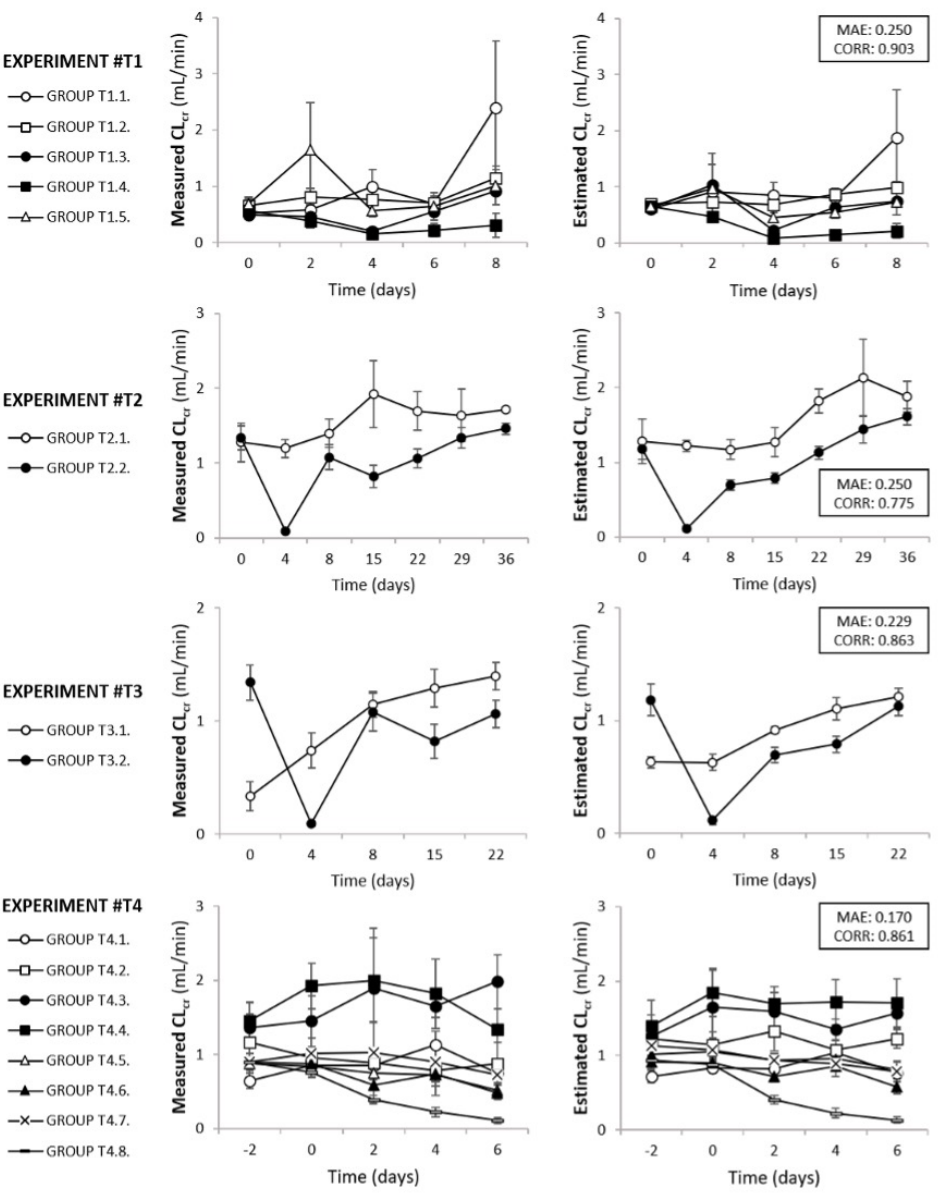
Figure 3. Comparison of the measured ClCr and estimated ClCr, corresponding to four exemplifying actual experiments, using data from the test set. ClCr, creatinine clearance. CORR, Pearson product-moment correlation coefficient. MAE, mean average error.